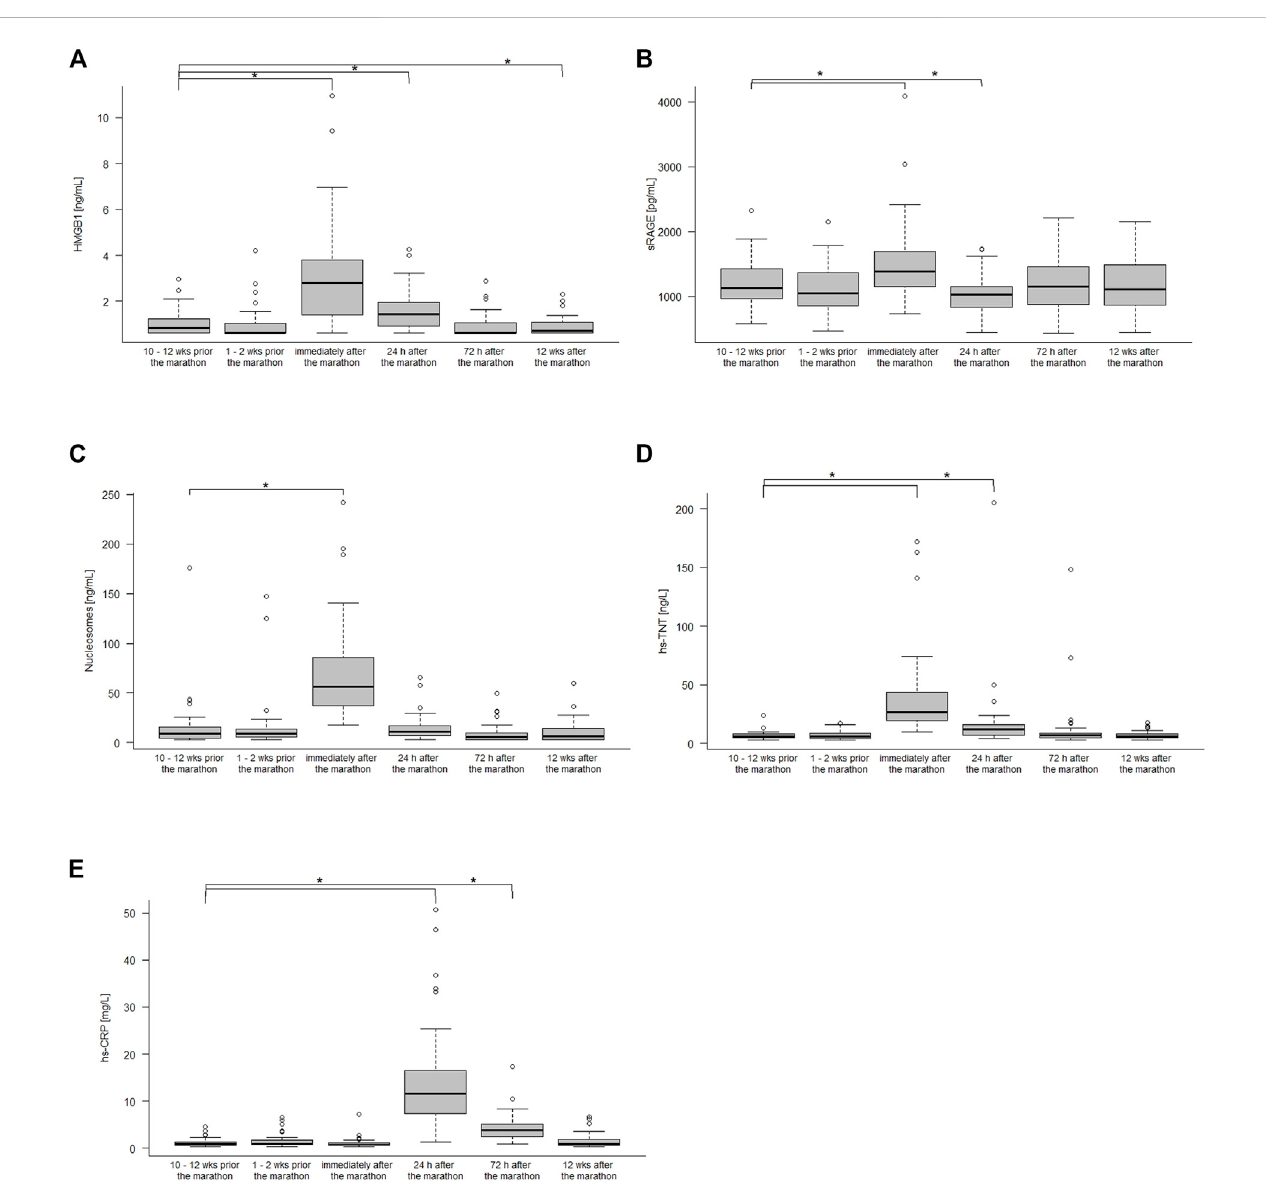
FIGURE 1 HMGB1 (A) ,sRAGE (B) ,nucleoseome (C) ,hs-TnT (D) ,andhs-CPR (E) concentration10 – 12 weeks,1 – 2 weeksbeforethemarathon,immediatelyafterthe marathon,24 h,72 hafterthemarathonand12 weeksafterthemarathon.Boxplotsshowmedianandtheinterquartilerange(IQR);* p < 0.05comparedtothe baseline